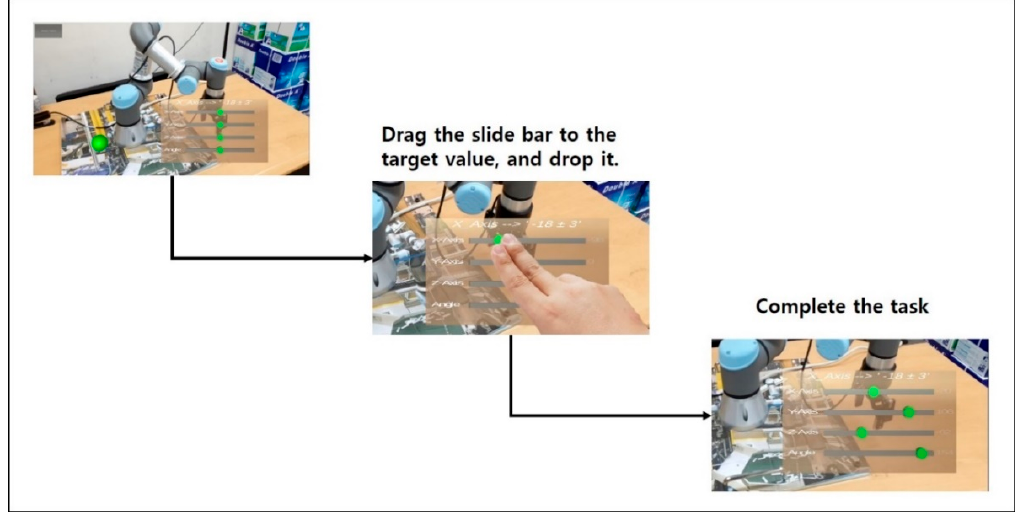
Figure 13. Dragging and dropping task for manipulating the robot with a slide bar for changing joint angles and moving the robot along an axis.